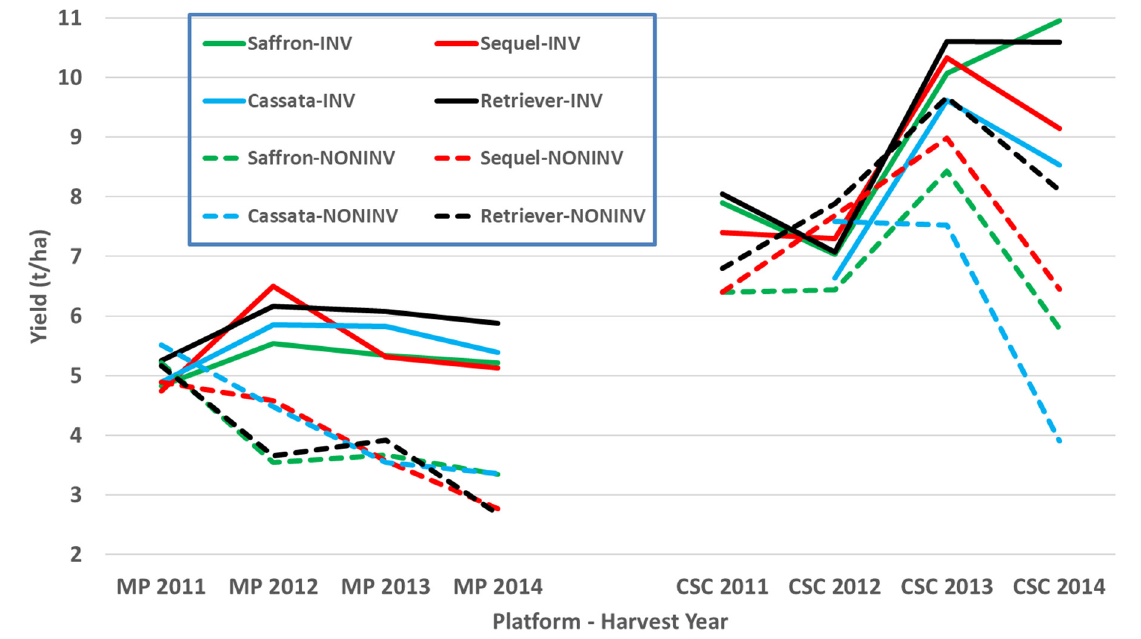
Figure 14. Comparison of cultivar yields under inversion (INV) and non-inversion (NONINV) tillage in two different cropping platforms, Mid Pilmore (MP) and the Centre for Sustainable Cropping (CSC).